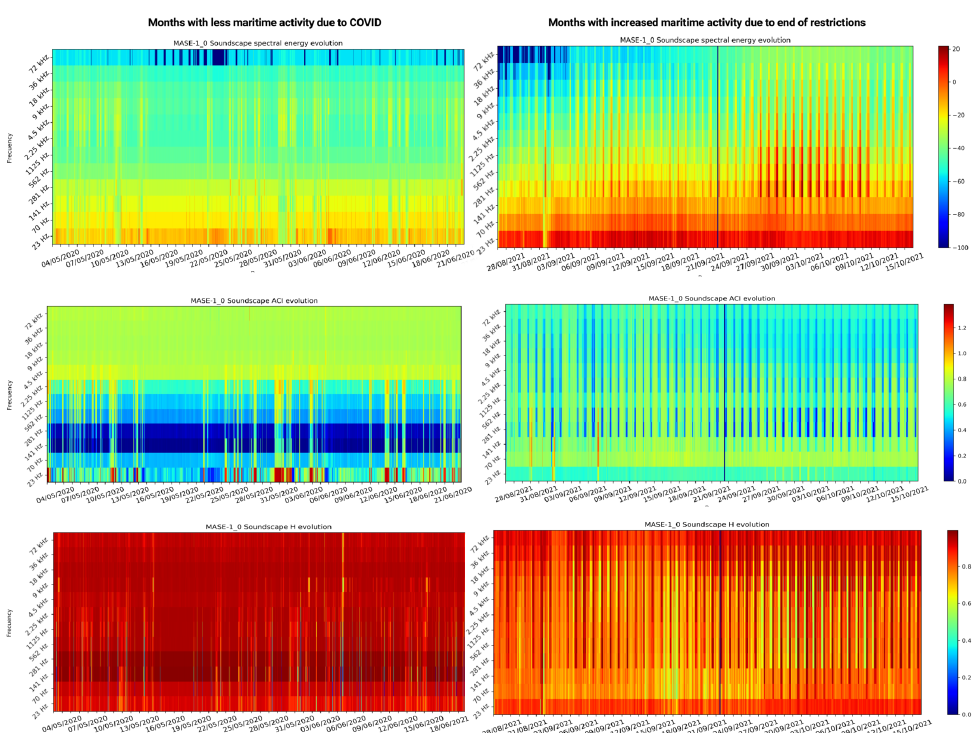
Figure 10. Indices obtained during confinement vs. reactivation of maritime activity (energy spec- trum, ACI, and H t